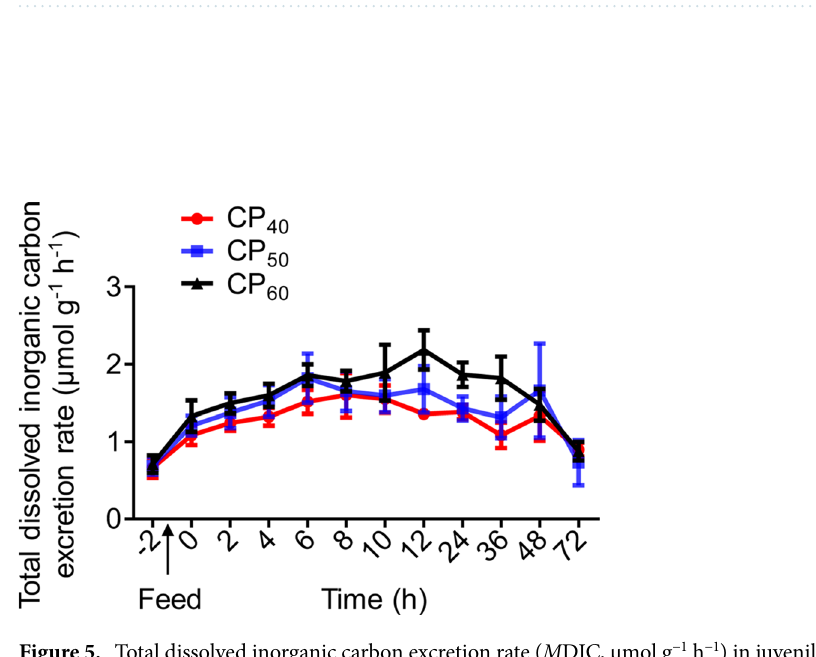
Table 3. Characteristics of total dissolved inorganic carbon excretion ( M DIC) in juvenile Sagmariasus verreauxi . Lobsters were reared at 21 °C and fed 15 N-labeled feeds at 1.5% body weight at three crude protein levels: 40%, 50% and 60%, corresponding to CP 40 , CP 50 and CP 60 treatments, respectively. M DIC peak , peak M DIC. All data represent mean ± standard error (SE) of 5 to 6 individuals. Different superscripts (a, b) in each row indicate significant differences among treatments (One-way ANOVA, P < 0.05).